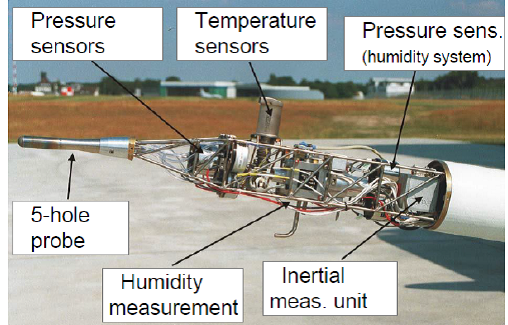
Figure 2. Nose boom and instrumentation of the research aircraft Dornier 128-6 D-IBUF. Photo: Mark Bitter, TU Braunschweig